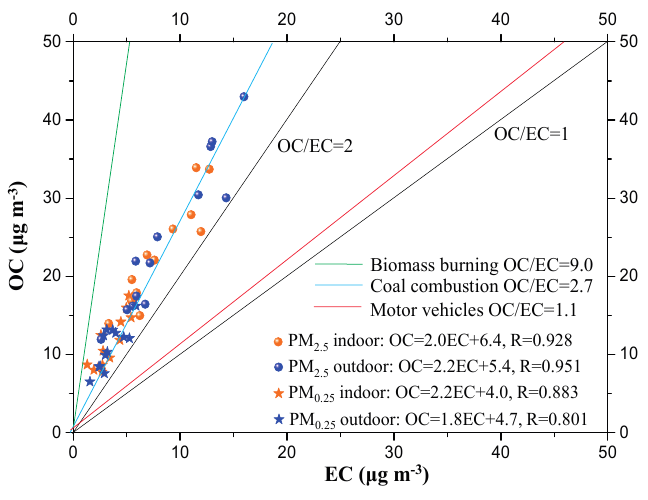
Figure 3. OC-to-EC ratios (OC/EC) in PM 2.5 and PM 0.25 inside the classroom and